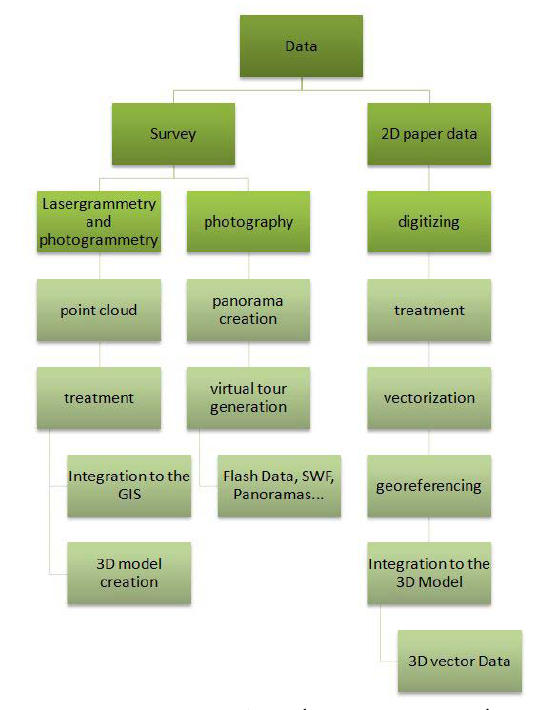
Figure 1. Scheme of data (origin and